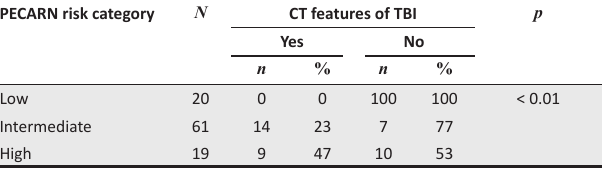
TABLE 2: Association between PECARN risk category and computed tomography features of a traumatic brain injury.